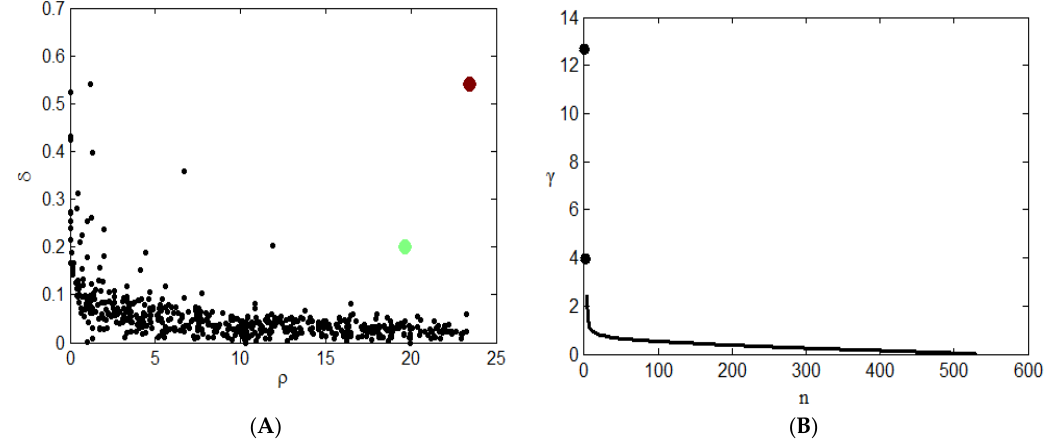
Figure 3. Clustering diagram. ( A ) The ρ and δ values of each point; ( B ) The γ values of each point.